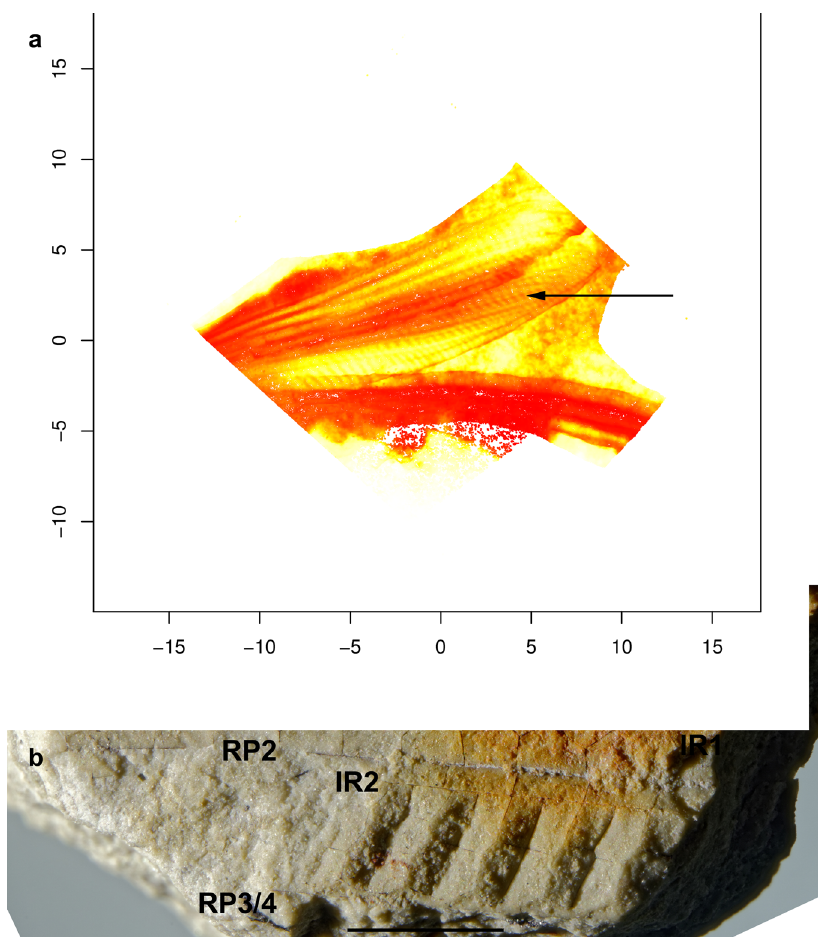
Fig. 3 Odonata Steleopteridae with specialized zones probably producing light fl ashes. a Parasteleopteron guischardi Fleck et al. 33 (Jurassic), holotype SOS 3615. False colors showing the relative reliefs of surfaces; arrow specialized zone; deep zones in red, higher zones in yellow. b Steleopteron cretacicus Zheng et al. 34 (Lower Cretaceous), showing differences of luminosity of parallel surfaces in specialized zone. RP2, RP3/4 branches of radius posterior, IR2 longitudinal intercalary vein. Scale bar: 2